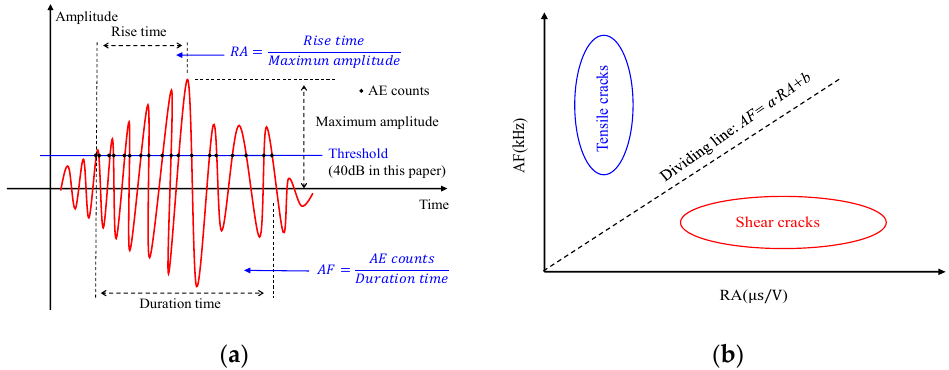
Figure 9. A method to distinguish microcrack by acoustic emission parameters: ( a ) AE parameters; ( b ) microcrack distribution (modified from [37]).